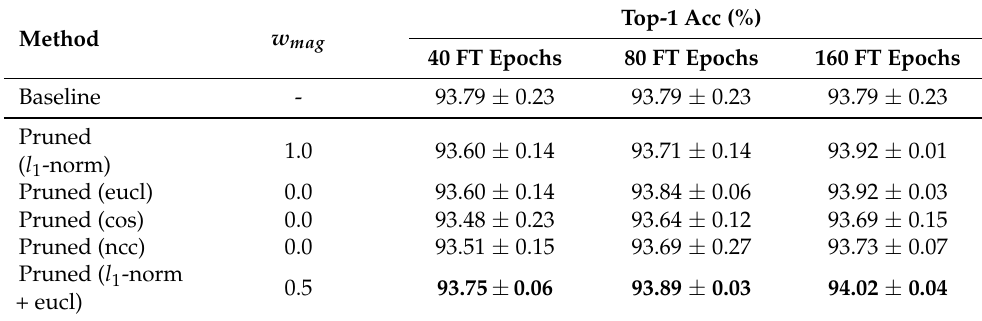
Table 1. Pruning VGGNet on the CIFAR-10 dataset using different filter selection criteria and a different number of fine-tune epochs. ’FT epochs’ means ’Fine-tune epochs’.